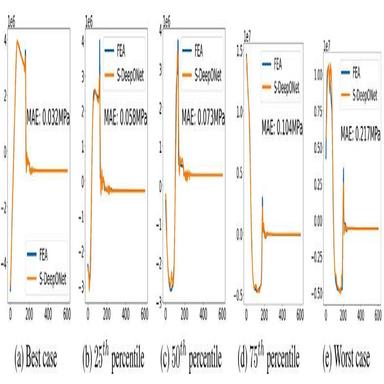
Stress predictions by S-DeepONet compared to multiphysics FEA simulations in test dataset.